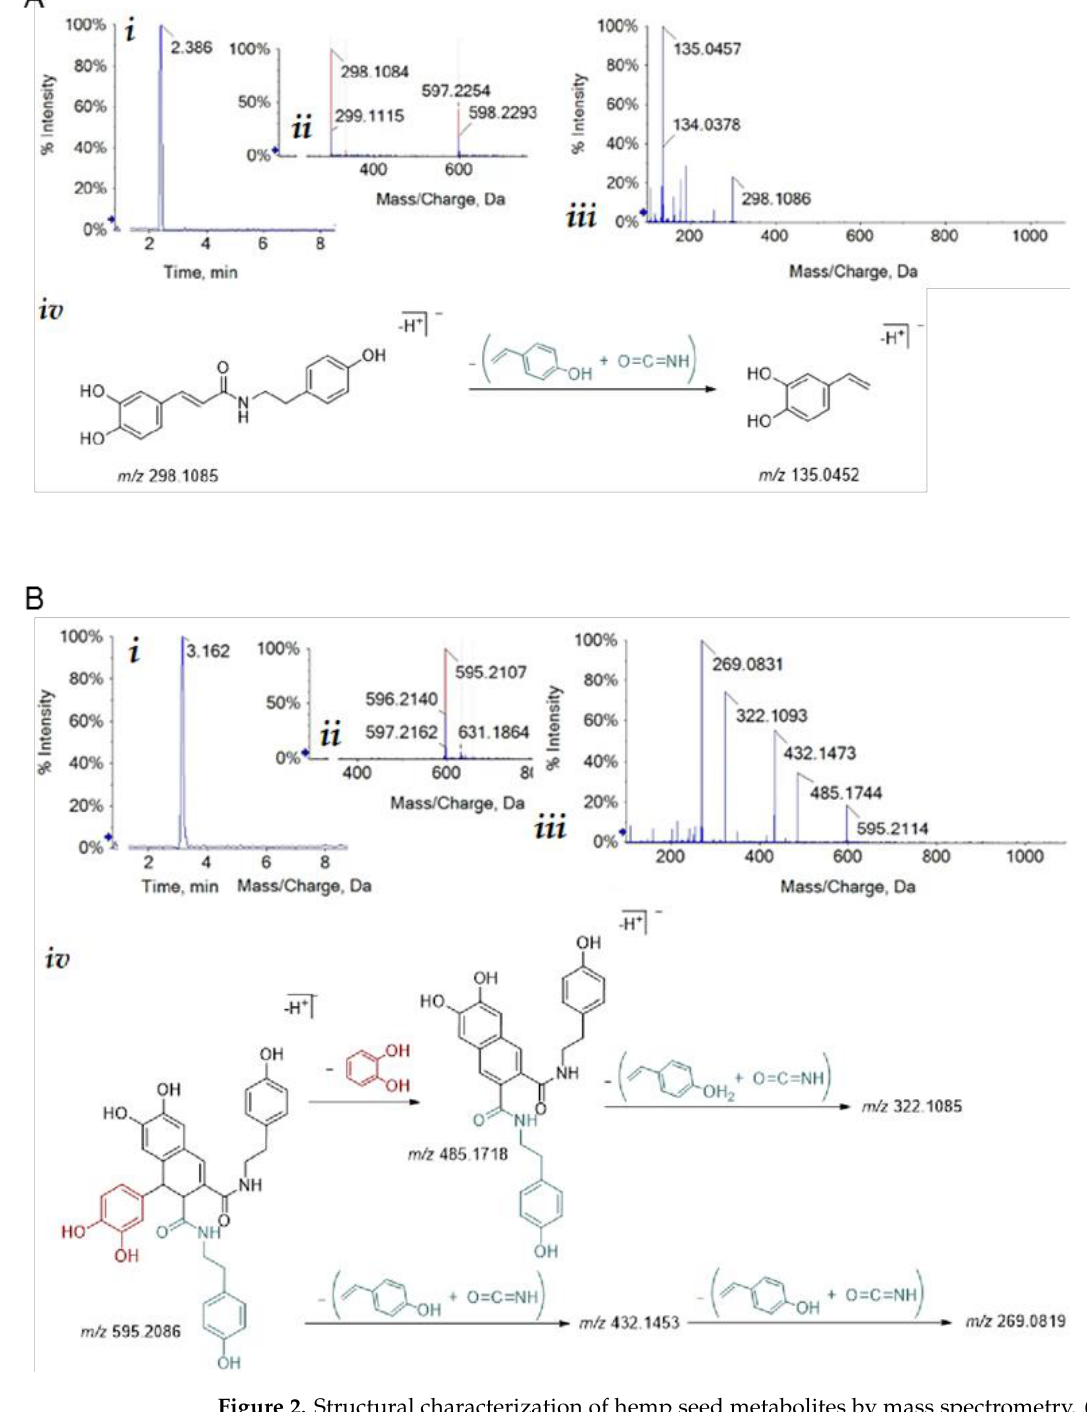
Figure 2. Structural characterization of hemp seed metabolites by mass spectrometry. ( A ) N-trans - caffeoyltyramine (i) Total Ion Chromatogram (TIC); (ii) TOF-MS spectrum showing the [M-H] - and [2M-H] - ions at m/z 298.1084 and 597.2254, respectively; (iii) TOF-MS/MS of the [M-H] - ion; (iv) pro- posed fragmentation pattern; theoretical m/z value is below each chemical structure. ( B ) Cannabisin B (i) Total Ion Chromatogram (TIC); (ii) TOF-MS spectrum showing the [M-H] - ion at m/z 595.2107; (iii) TOF-MS/MS of the [M-H] - ion; (iv) proposed fragmentation pattern; theoretical m/z value is below each chemical